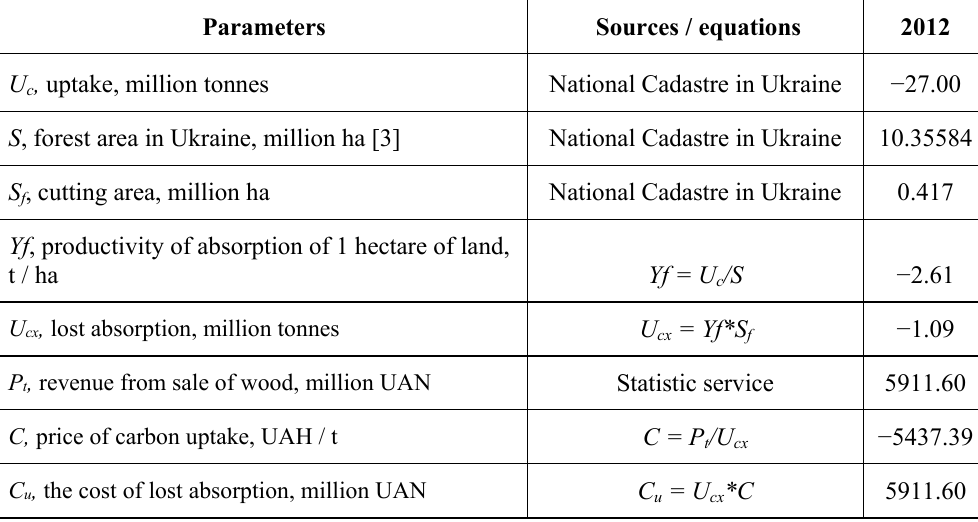
Table 3. Calculation of Payment for Deforestation in